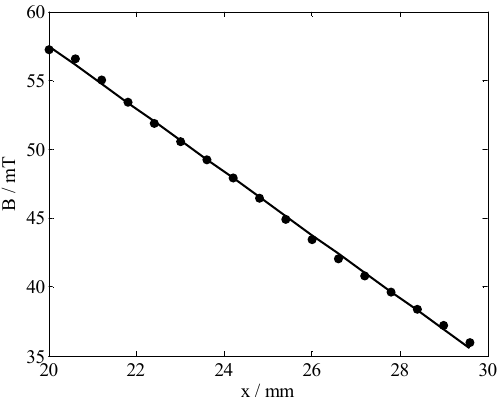
Figure 4. Magnitude of the magnetic field as a function of depth over the center of magnets.